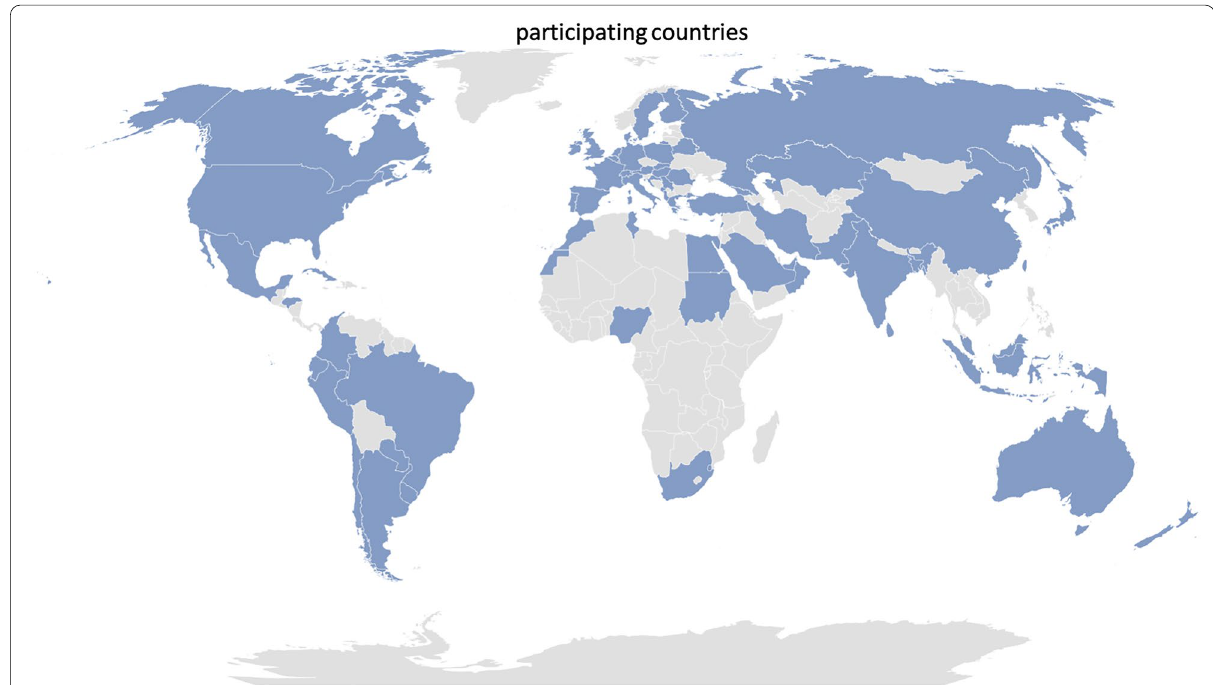
Fig. 1 Countries from which participants took part in the A-TEAMICU survey